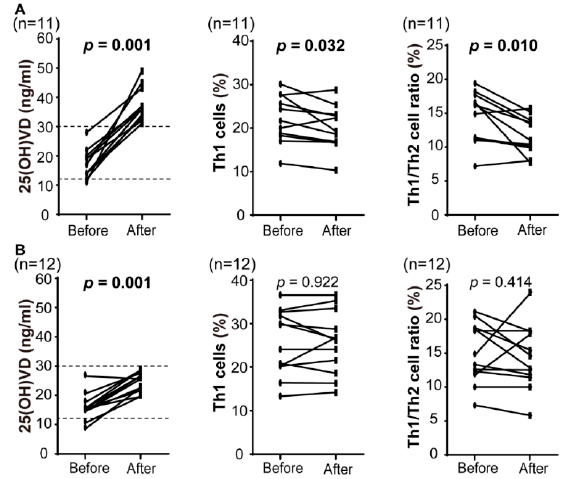
Figure 2. Immunological alteration after VD supplementation in infertile women. A change in serum 25(OH)VD, Th1 cell, and Th1/Th2 cell ratio after intake of VD (cholecalciferol) at 1000 IU per day for 3 months in the infertile patients with VD insufficiency or deficiency. Normal range of Th1 (CD4 + /IFN- γ + )/Th2 (CD4 + /IL-4 + ) cell ratio is <10.3 ( dotted lines ). Of 23 patients, 11 reached above normal range